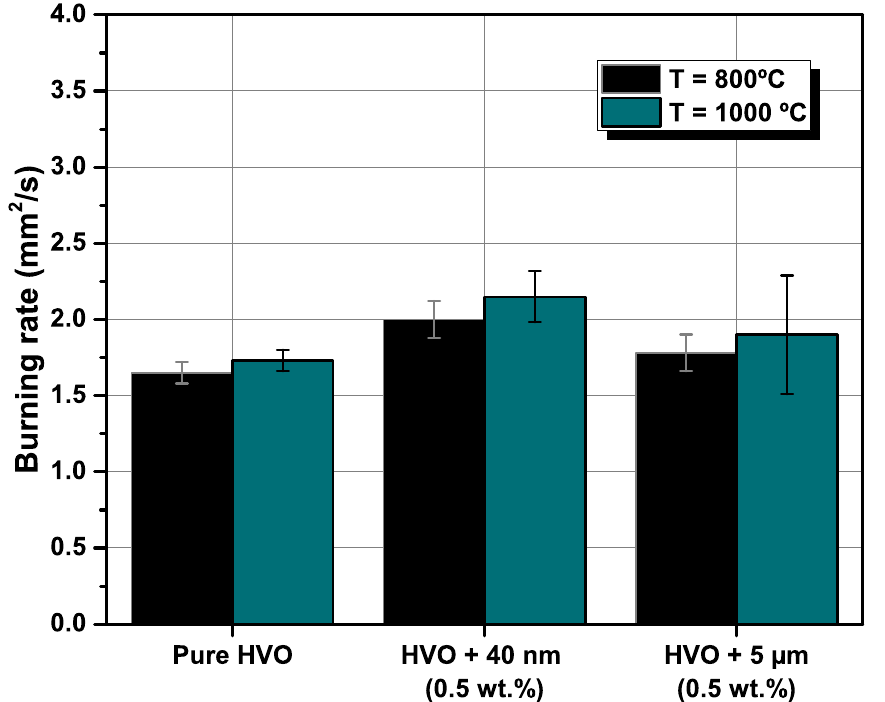
Figure 16. Burning rate for pure HVO and HVO + Al particles at T = 800 ◦ C and T = 1000 ◦